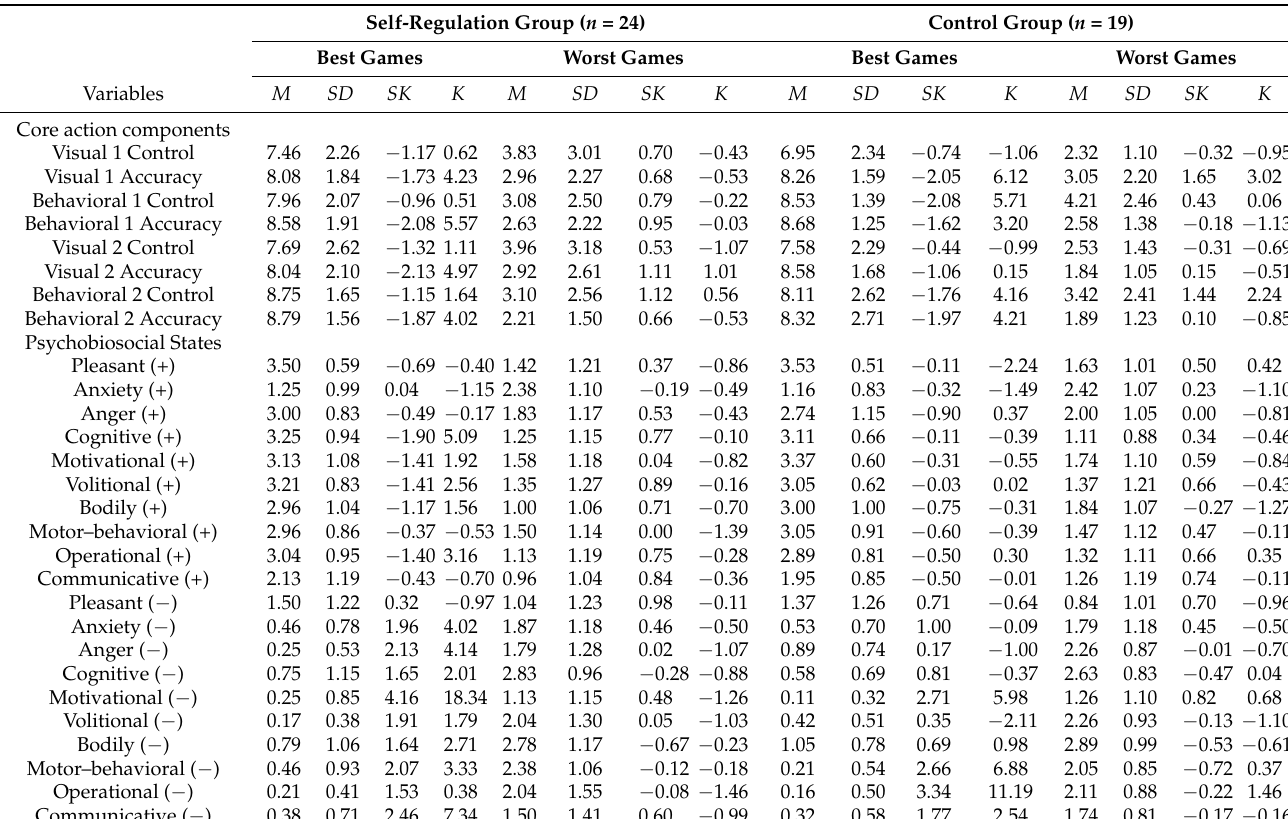
Participants’ mean scores in the imagery ability subscales at phase one (pre-intervention) are depicted in Figure 2. There were no significant differences in the imagery ability subscale scores across SR and C group players, Wilks’ λ = 0.483, F (12, 18) = 1.604, p = 0.107, η p 2 = 0.517. Their imagery ability was deemed sufficient to follow the study protocols. Table 1. Descriptive statistics for players’ psychobiosocial states and core action components in recalled best and worst games for participants in the self-regulation and control groups. Self-Regulation Group ( n = 24) Control Group ( n = 19) Best Games Worst Games Best Games Worst Games Variables